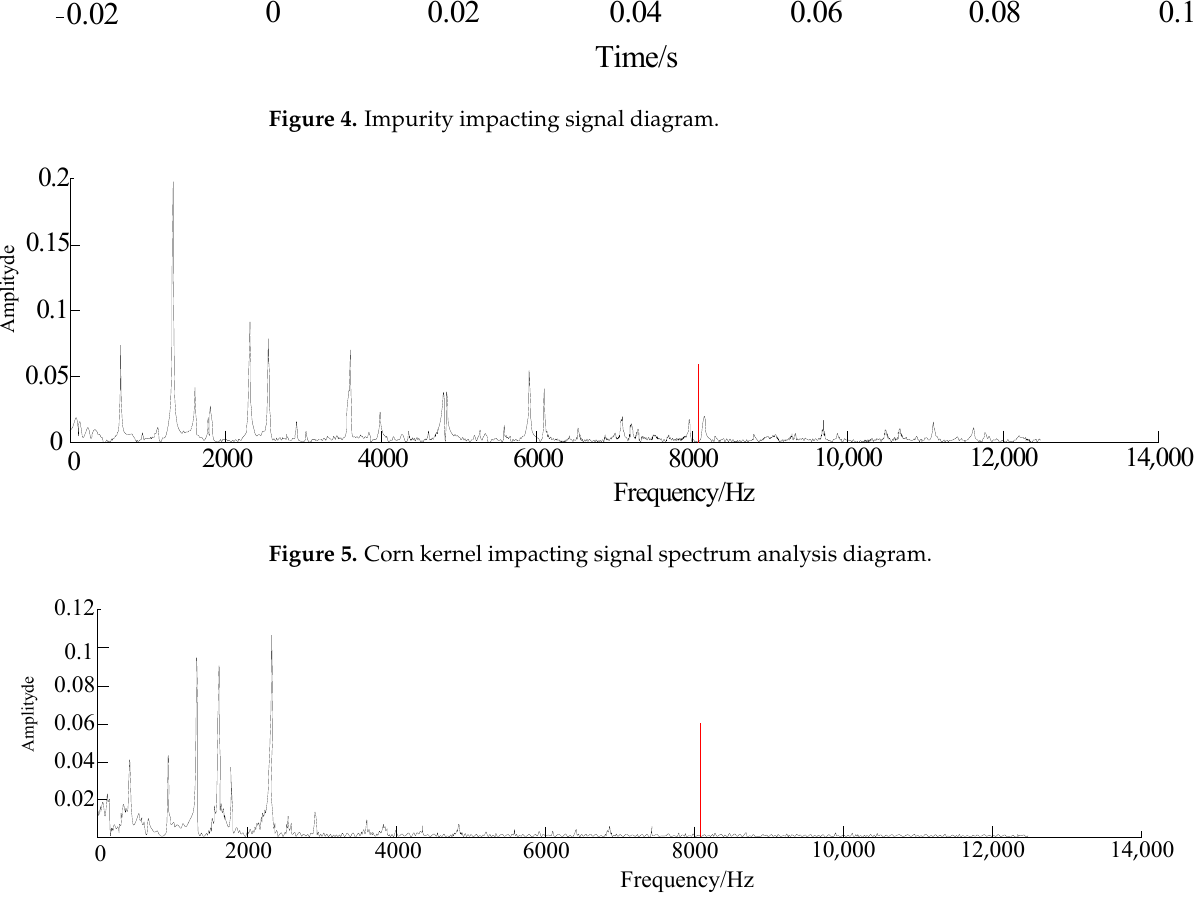
Figure 5. Corn kernel impacting signal spectrum analysis diagram.